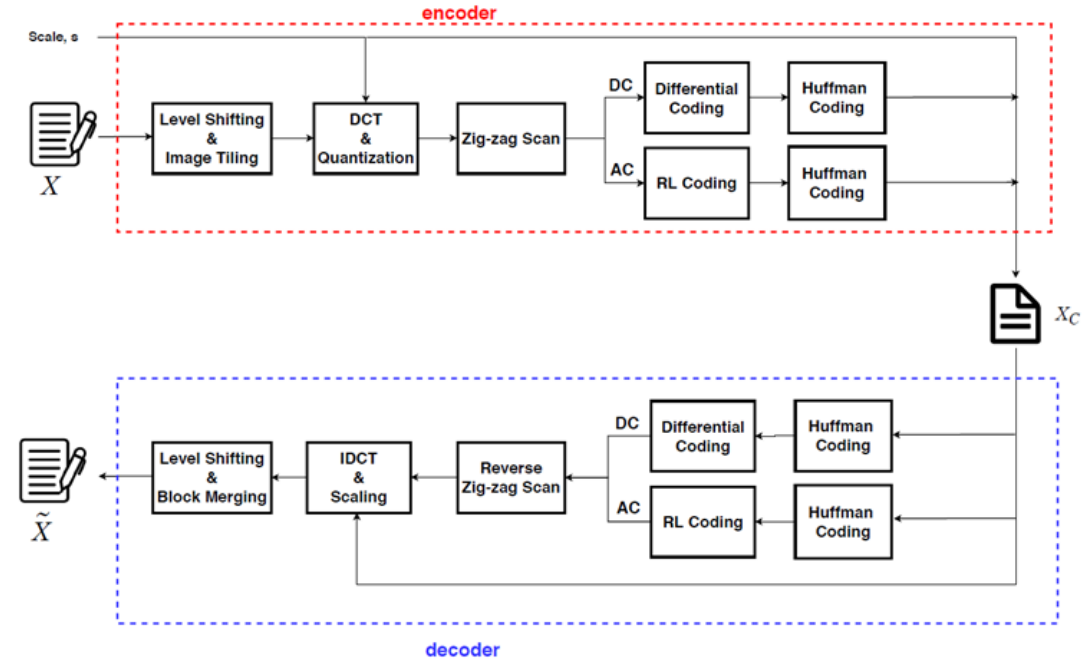
Figure 4. Framework of the DCT-based